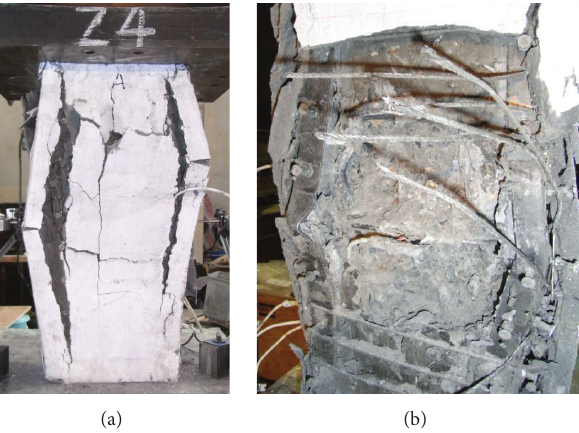
Figure 4: Typical failure mode of strengthened